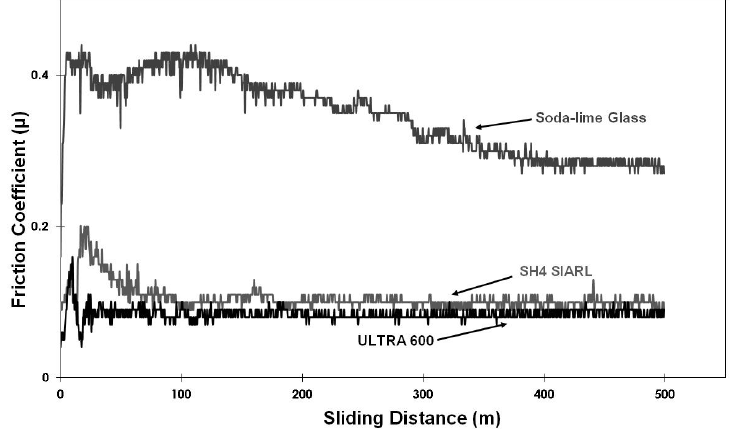
Figure 2. Friction coefficient vs. sliding speed for the tribosystem: (a) bare soda-lime glass–stainless steel; (b) SH4 SIARL coating–stainless steel; and (c) ULTRA 600 coating–stainless steel.